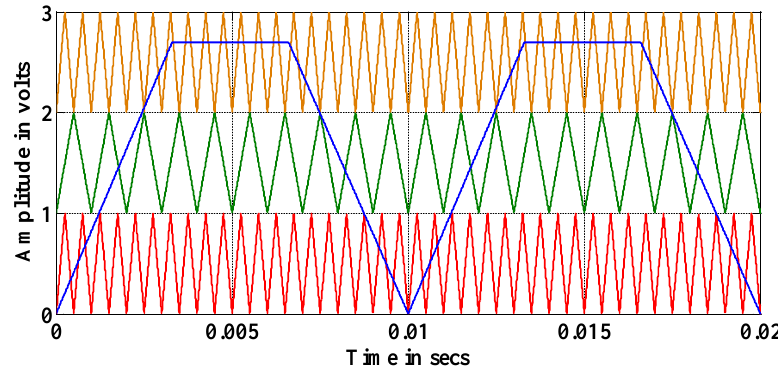
Figure 5. Carrier arrangement for the VFPWM strategy.